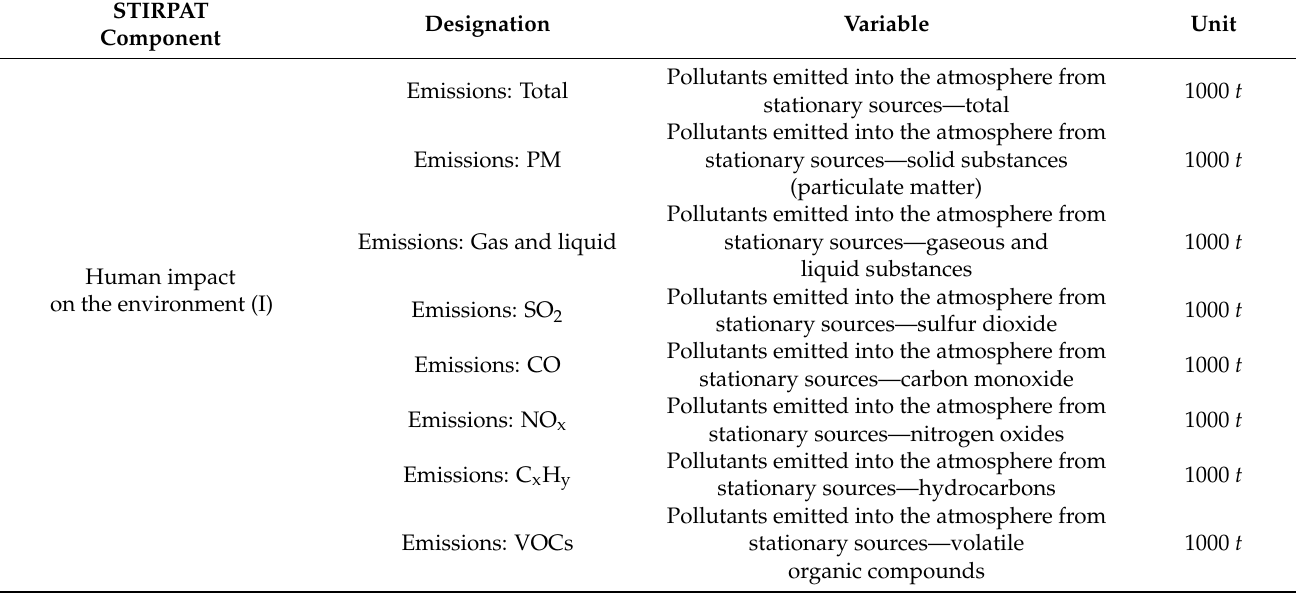
Table 2. Definitions of variables for STIRPAT analysis. Source: compiled by the authors using the data available from Rosstat (https://www.gks.ru/dbscripts/munst/ (accessed on 15 July 15 2021)). STIRPAT